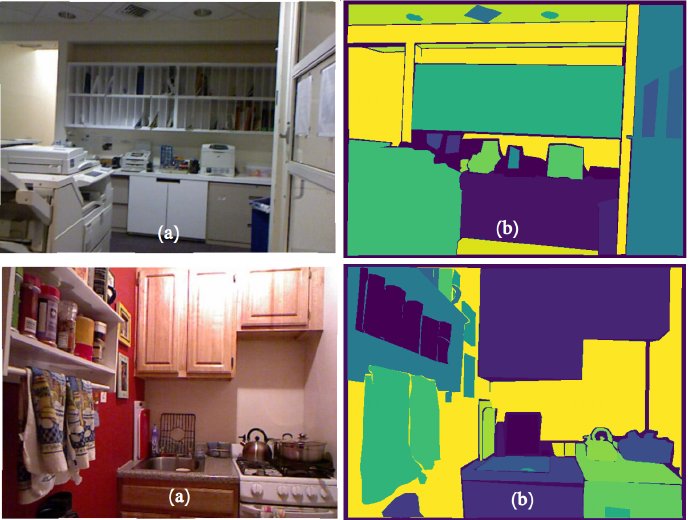
Figure 18. Panoptic segmentation of indoor scenes from the NYUv2 dataset examples. Real RGB images are on the left ( a ) and ground truth panoptic segmentations are on the right ( b ).